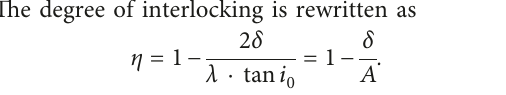
Figure 3: The definition of degree of interlocking (after Ladanyi and Archambault [2]). η is the degree of interlocking, δ is the fracture opening, and A and λ are the asperity amplitude and wavelength,